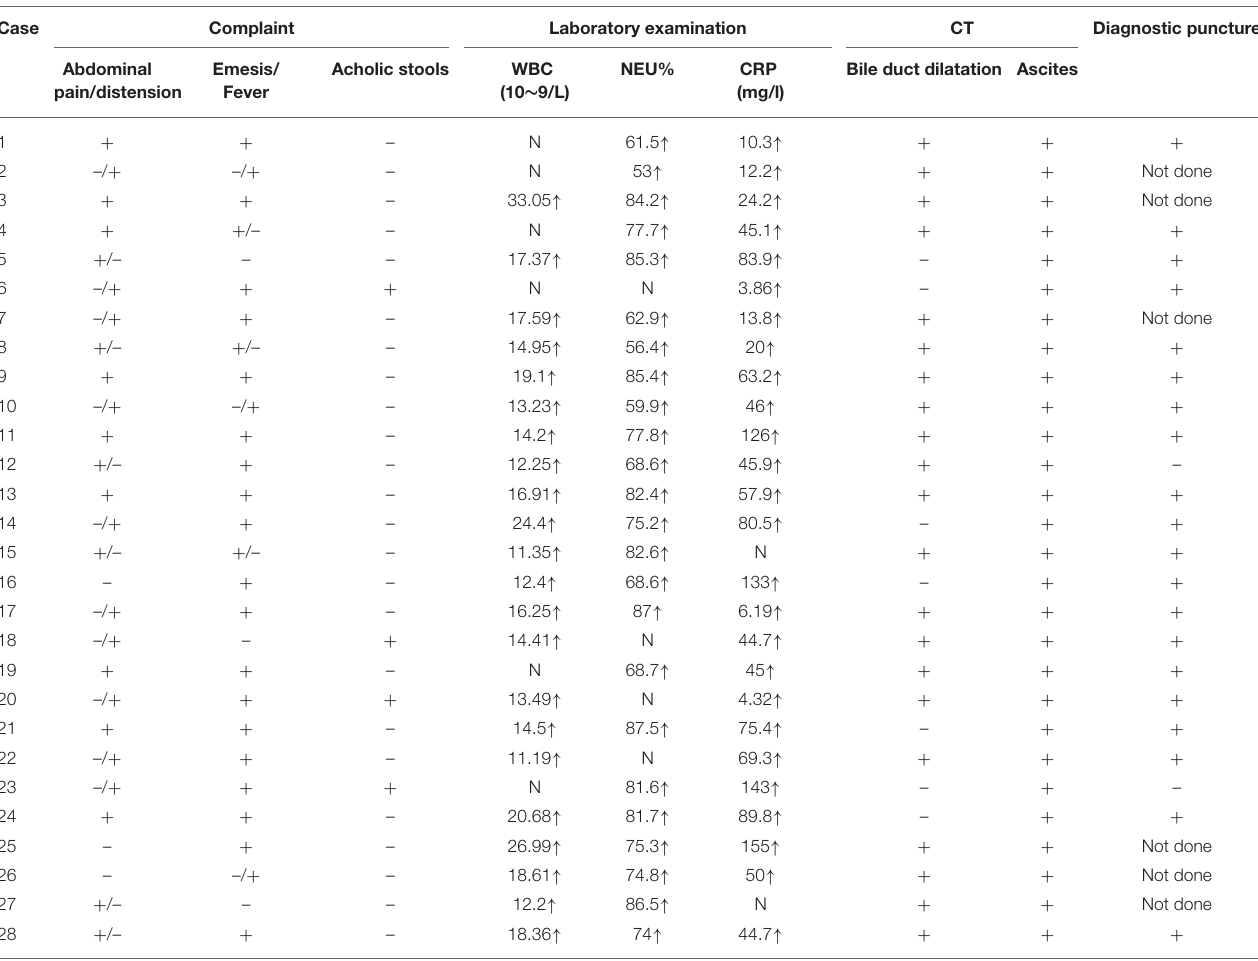
TABLE 1 | Preoperative features of